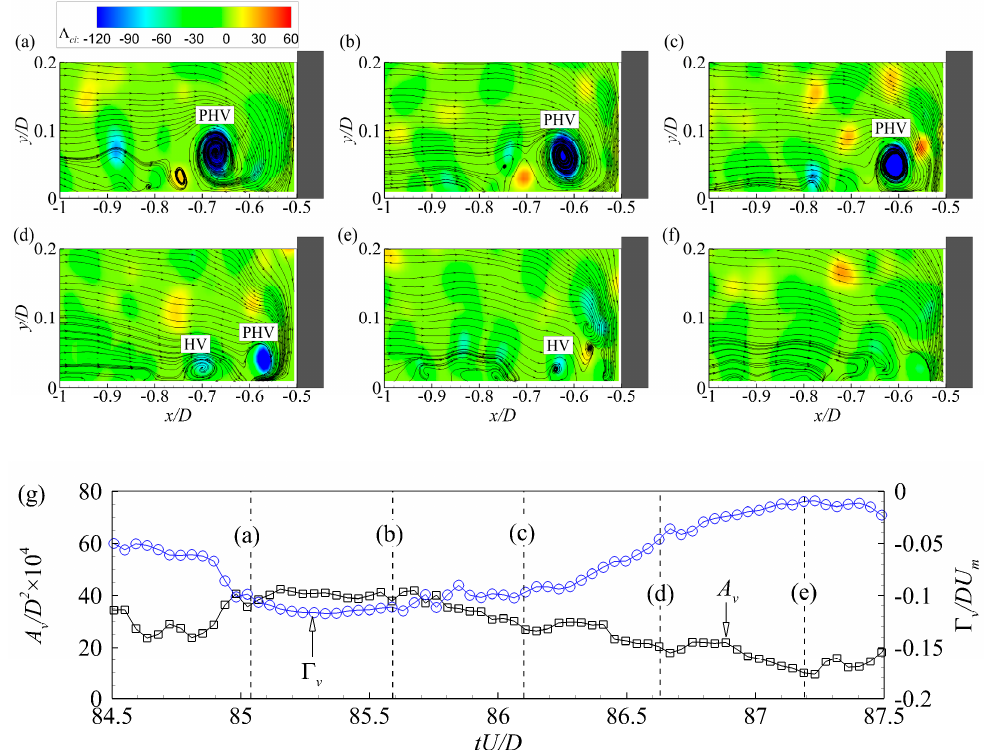
Figure 15. ( a – f ) Sequence of instantaneous velocity fields illustrating a PHV dissipating in the junction region, and ( g ) variations of the core area and circulation strength during the dissipation process for case C13900. Each dashed line in ( g ) indicates the time of the flow field labelled by the letter.